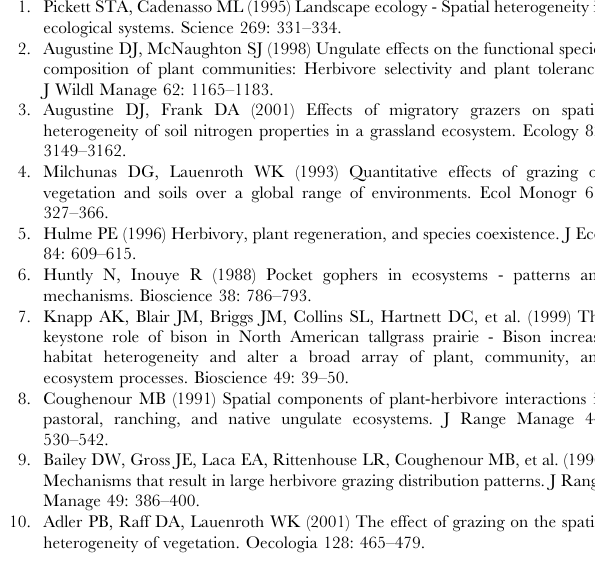
Table S5 ANOVA results on removal of Sargassum myriocystum lateral branches at three sites and nine distances from the reef flat/lagoon